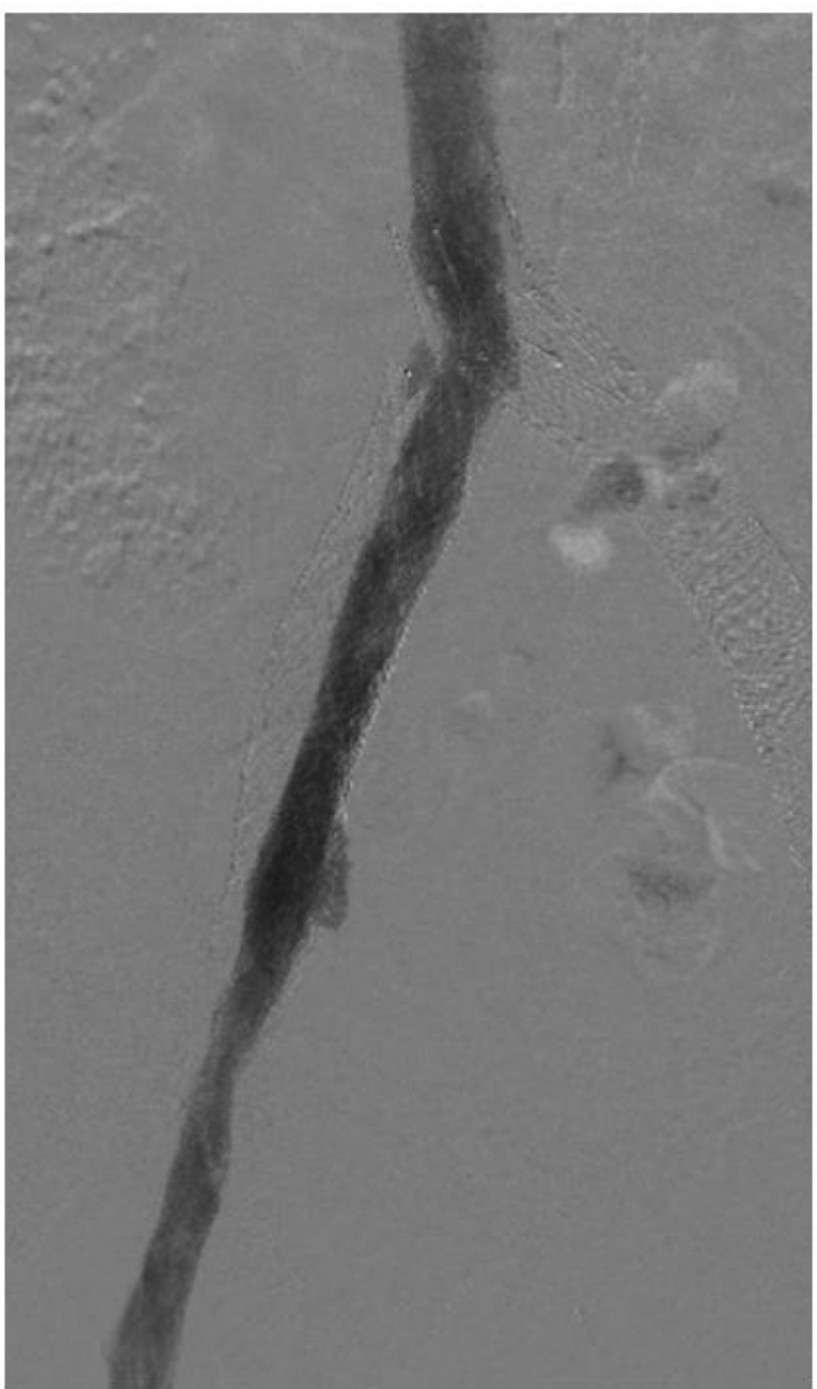
Figure 3. Venogram showing in-stent restenosis in the stent (about 50%). Notice that the contrast does not completely fill the stent